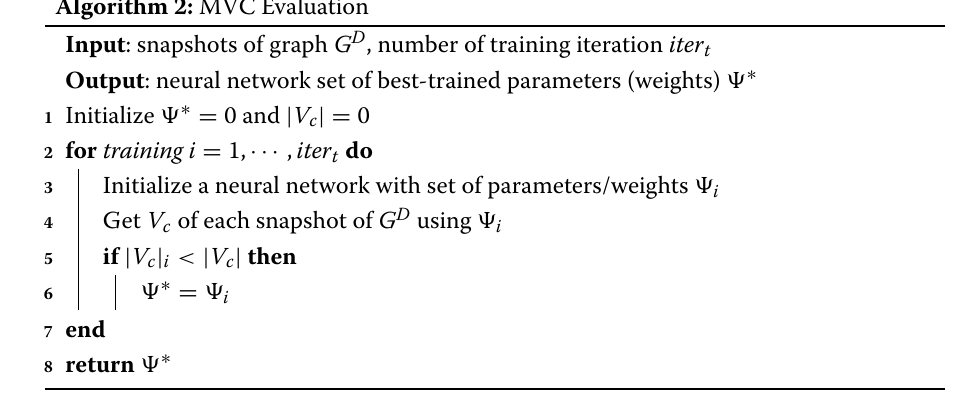
Algorithm 2: MVC Evaluation